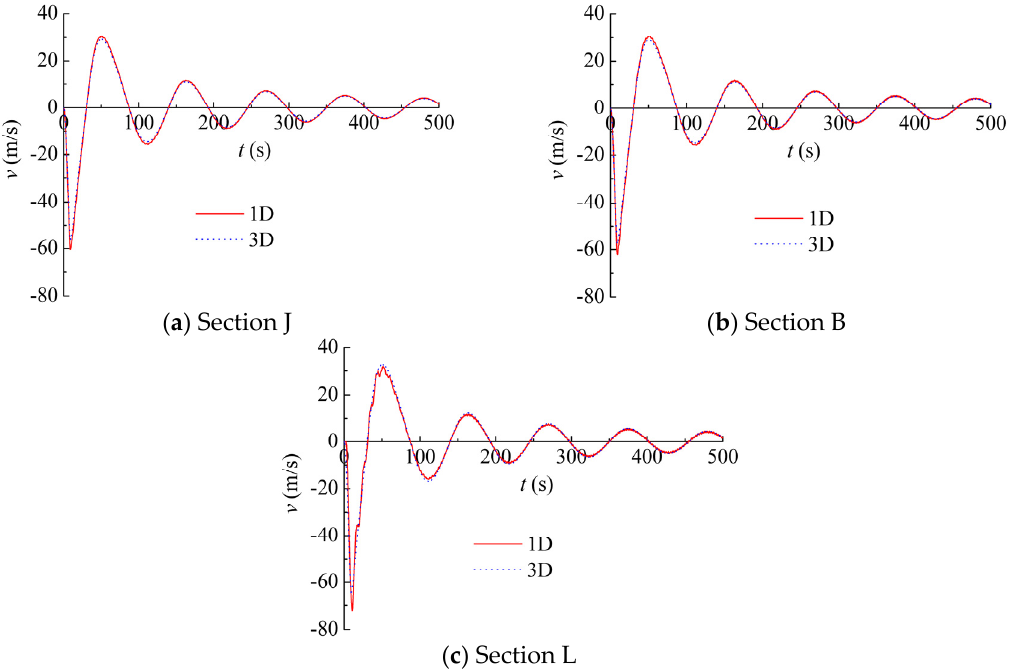
Figure 8. The comparison of the wind speed fluctuation processes of typical sections as simulated by using 1D and 3D methods. Table 1. The comparison of positive and negative wind speeds (extrema) in typical sections.